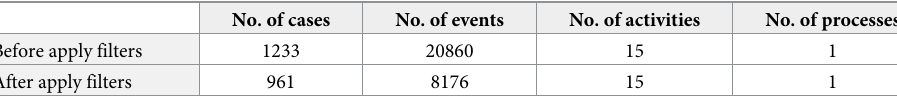
Table 2. Event data before and after applying preprocessing